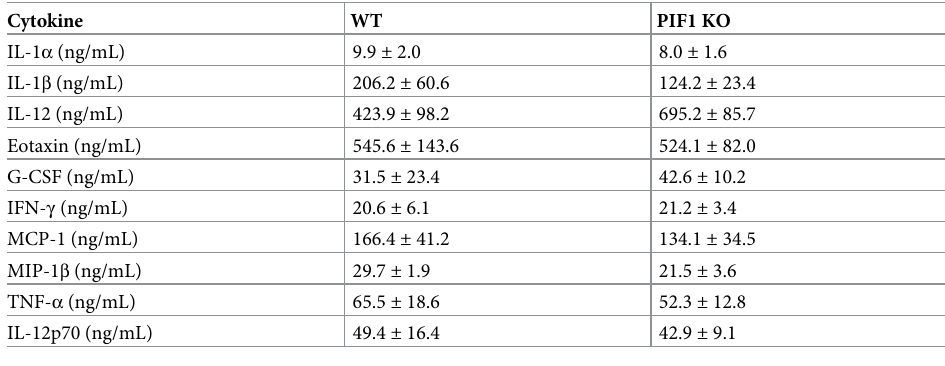
Table 2. Cytokines measured in serum from Western diet-fed, WT and PIF1 KO female